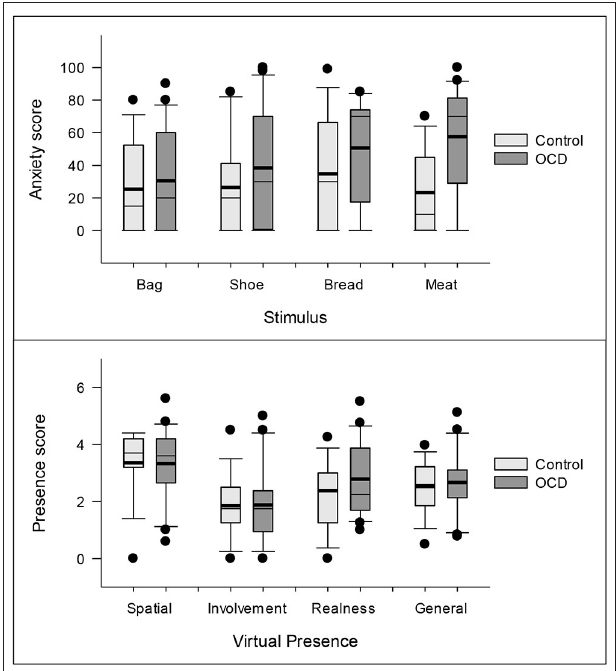
FIGURE 5 | Box plots for the anxiety and virtual presence scores across the control and clinical groups. The thin lines inside the boxes represent the median and the thick ones, the means. The circles represent the observations outside the 10–90th percentiles.